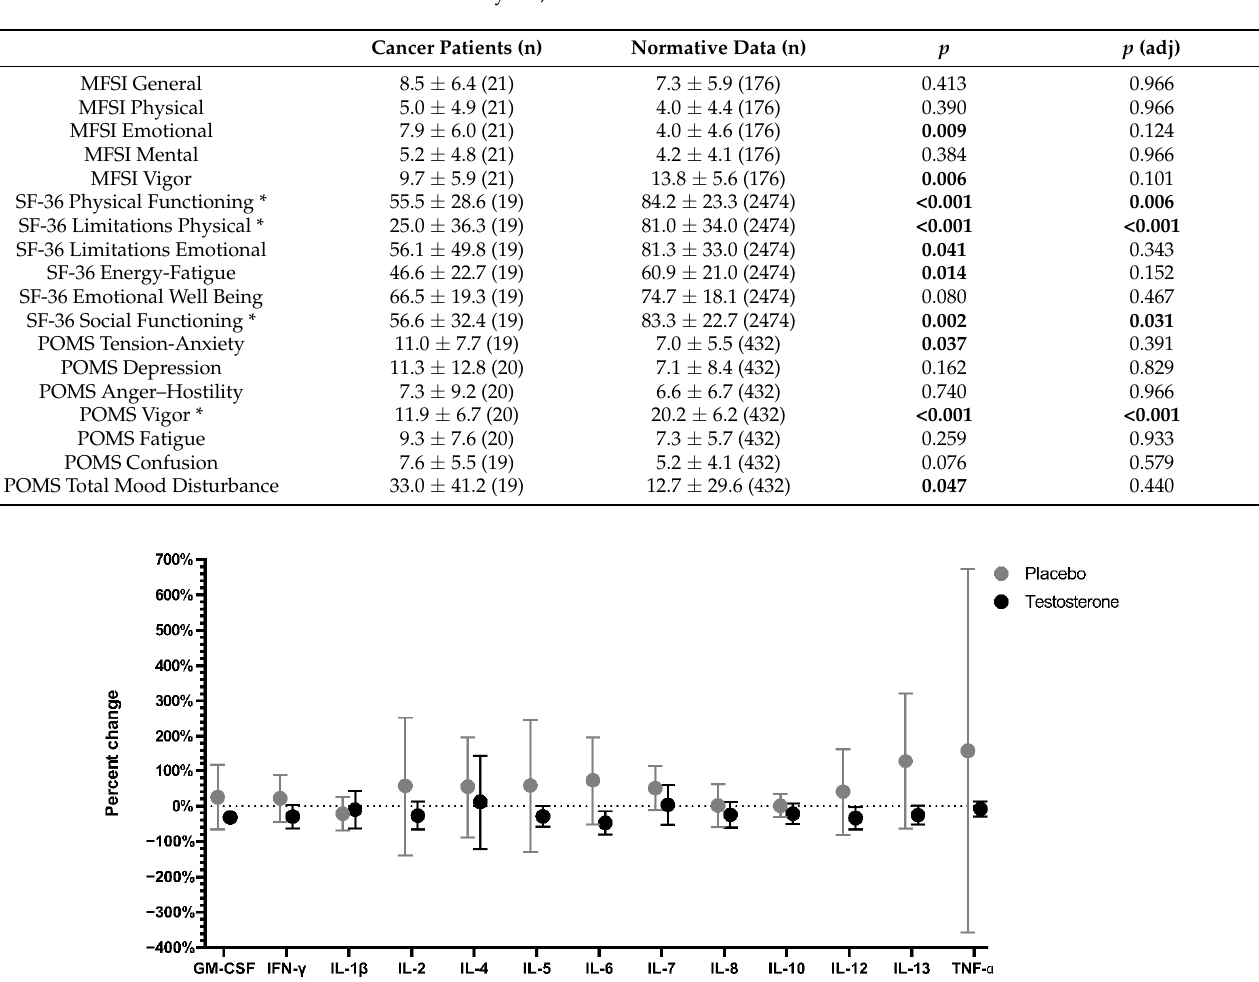
Table 2. Baseline MFSI, SF-36, and POMS scores (mean ± SD) for cervical or head and neck cancer patients compared to normative data. Questionnaire scores/subscales that were significantly differ- ent after correction for multiple testing are indicated with an asterisk. Normative data for MFSI, SF- 36, and POMS questionnaires from Cordero et al., 2012, Nyenhuis et al., 1999, and Ware et al., 1993, respectively. MFSI—Multidimensional Fatigue Symptom Inventory—Short Form, SF-36—RAND 36-Item Health Survey 1.0, POMS—Profile of Mood States—Short Form.